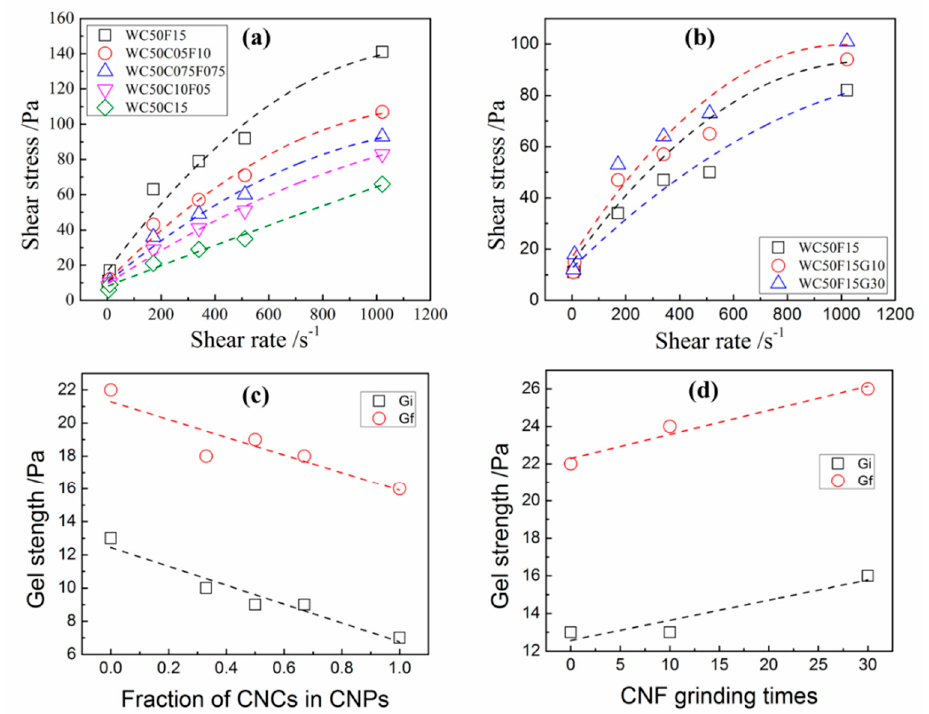
Figure 8. Plots of shear stress versus shear rate for CNP-OWC (( a ) mixture of CNC and CNF and ( b ) grinding CNF-OWC, dash lines are the fitted lines using MBM) and initial and final gel strength with different addition of CNPs (( c ) mixture of CNC and CNF and ( d ) reground CNFs).